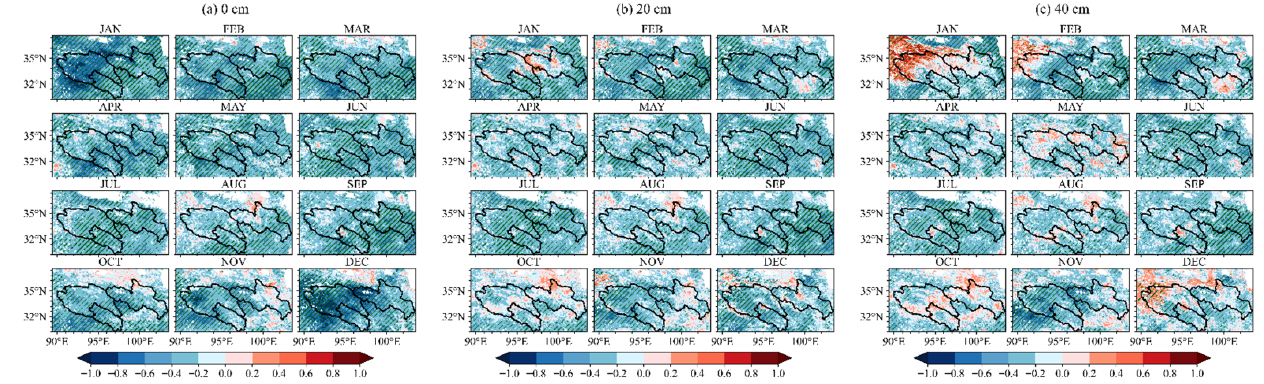
Figure 8. The correlation coefficient of SCD and soil temperature (slashed areas indicate passing the 95% significance test) at ( a ) 0 cm, ( b ) 20 cm, ( c ) 40 cm. Different from SCD, the NDVI index was generally positively correlated with soil